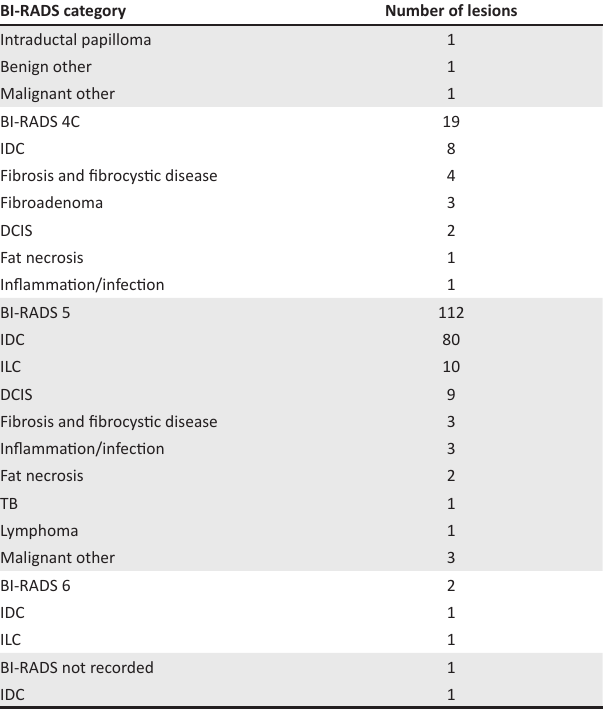
TABLE 2 (Continues...): Histological diagnoses of the ultrasound-guided core- needle breast biopsy in each BI-RADS category for lesions assessed with mammography and